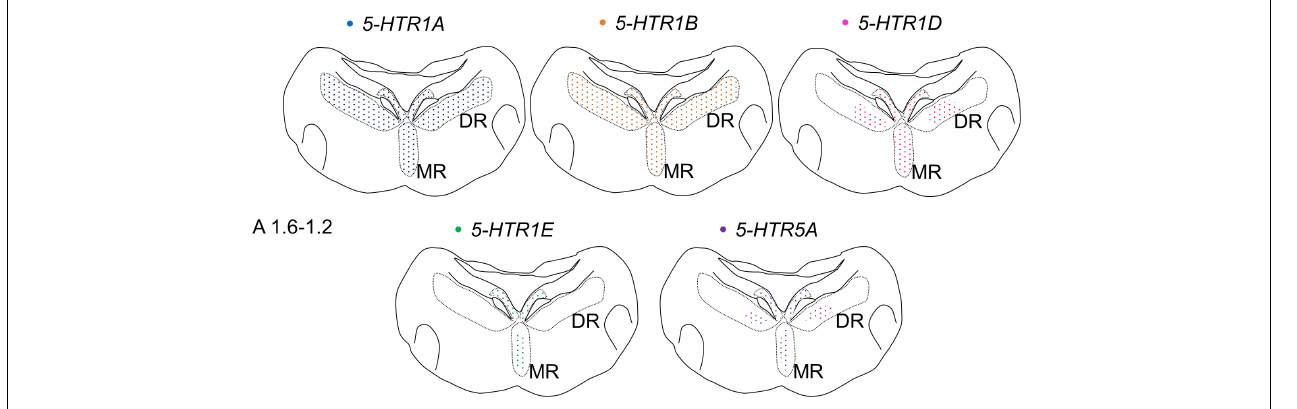
FIGURE 10 | Schematic summary of the expression patterns of 5-HTR1A, 5-HTR1B, 5-HTR1D, 5-HTR1E , and 5-HTR5A in the DR and MR in the P1 chick brainstems. Representative expression patterns in sections around A 1.6. A 1.2 are exhibited in colored areas (blue, 5-HTR1A ; orange, 5-HTR1B ; magenta, 5-HTR1D ; green, 5-HTR1E ; purple, 5-HTR5A ). The dotted pattern indicates that the expressed cells are sparsely distributed. The levels of the sections are in accordance with those mentioned in Kuenzel and Masson’s chick atlas (Kuenzel and Masson, 1988). DR, dorsal raphe; MR, median raphe; P1, post-hatch day